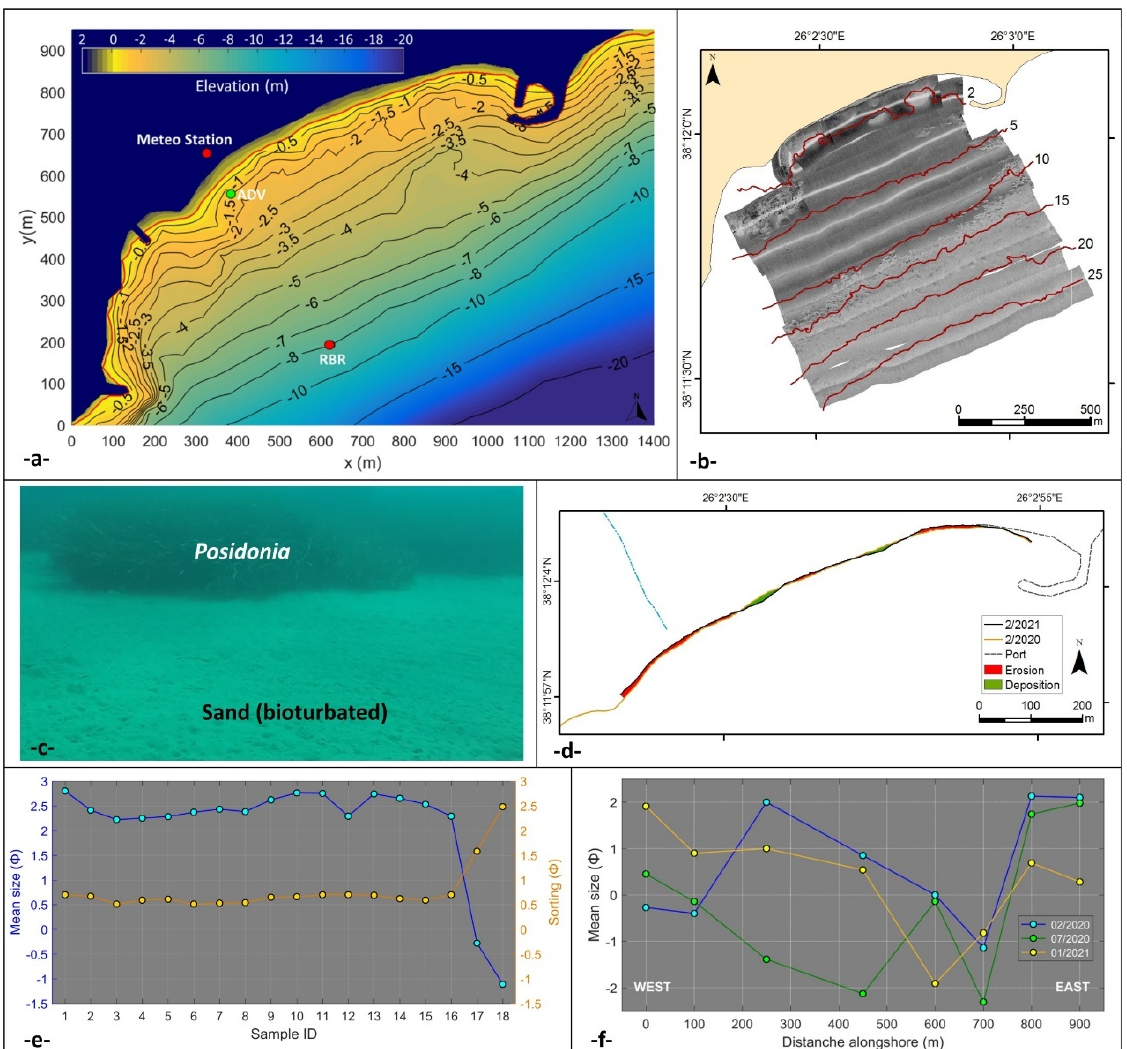
Figure 4. ( a ) Bathymetric chart of the inshore area, also showing the location of the deployed instruments (the red line represents the shoreline), ( b ) shallow water SSS mosaic (for interpretation see Section 3.4, Figure 8d), ( c ) underwater camera photo showing the boundary between Posidonia oceanica and sandy sediments at about 10 m depth, ( d ) one year shoreline location variability, ( e ) mean grain-size and sorting (in Ø units) variations of the inshore samples and ( f ) mean grain size (in Ø units) differences along the